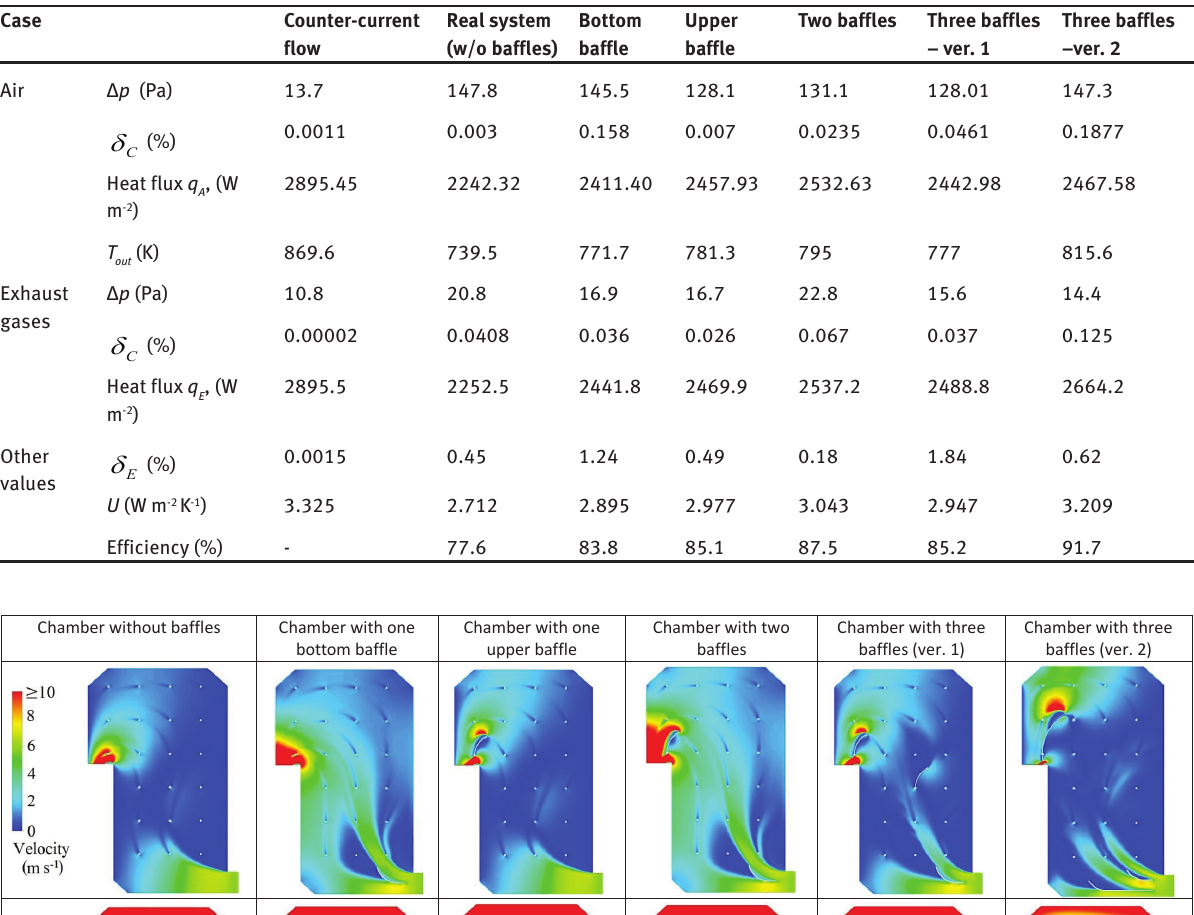
Table 3: Results of modelling.